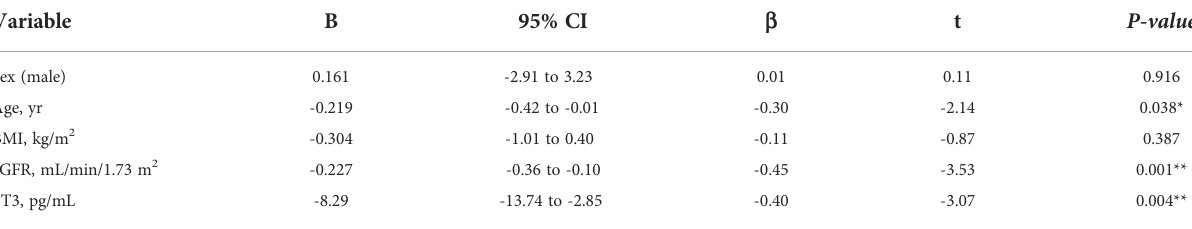
TABLE 6A Multiple regression analysis of D eGFR and variables in hypothyroidism. (A) Adjusted for sex, age, BMI, Post eGFR and FT3.